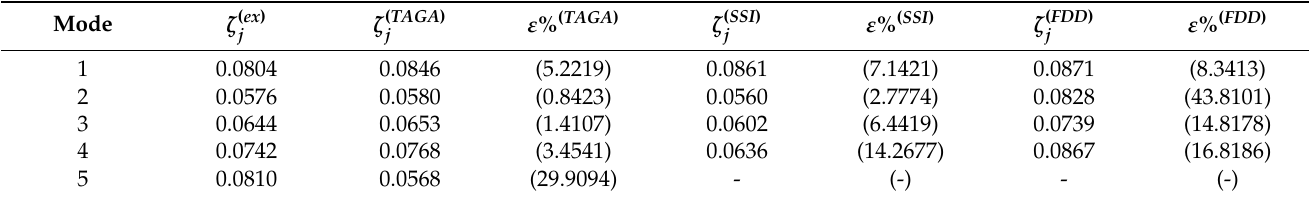
Table 8. Exact damping ratios, identified damping ratios, and corresponding discrepancies for the 5DoF